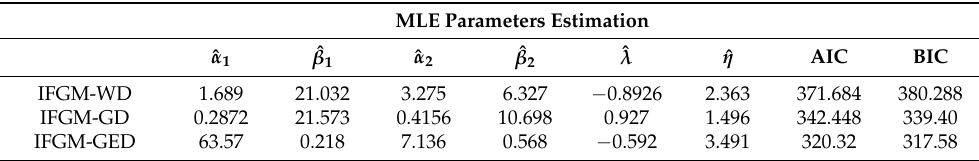
Table 2. Parameter estimation for IFGM distributions.